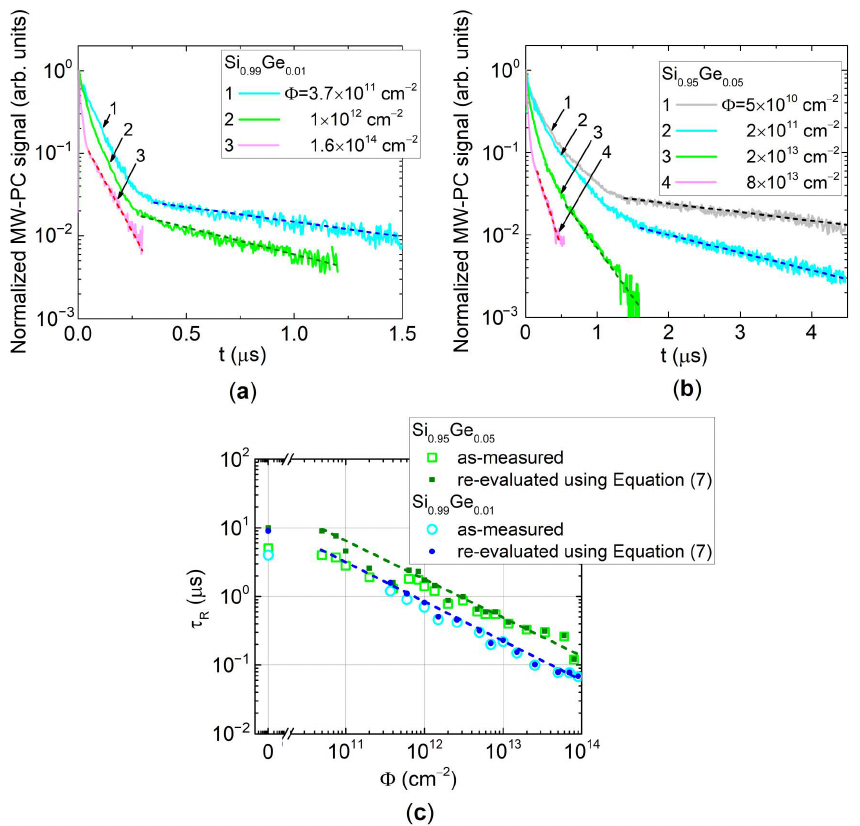
Figure 5. TheMW-PCrelaxationtransientsrecordedonSi 0.99 Ge 0.01 ( a )andSi 0.95 Ge 0.05 ( b )diodesirradiated with 1.6 MeV protons of varied fluence. ( c ) Carrier recombination lifetime as a function of 1.6 MeV proton fluence in Si 0.99 Ge 0.01 and Si 0.95 Ge 0.05 samples. Here, the MW-PC transients shown in ( a , b ) were in situ scanned during proton irradiation within stopping range of 1.6 MeV